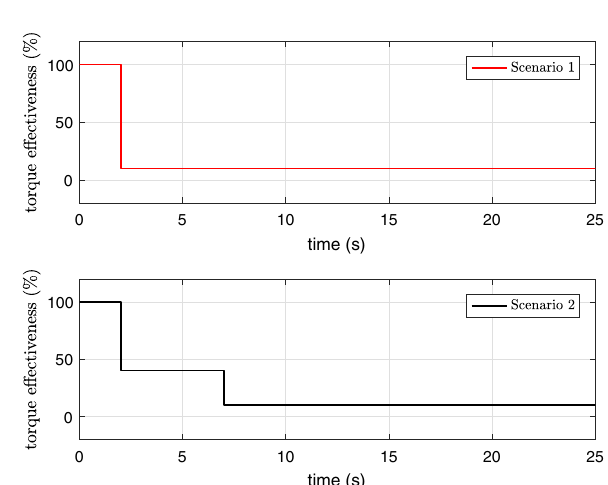
Figure 10. The profile of control effectiveness for two faults scenarios.